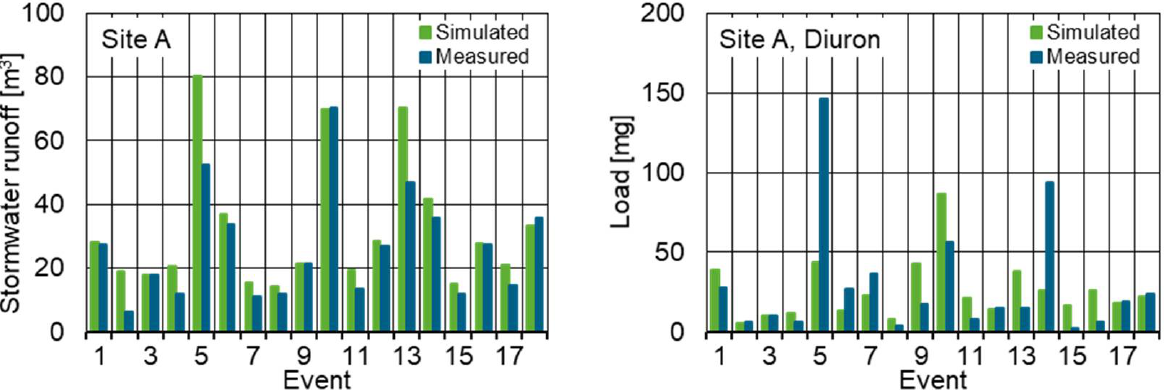
Figure 6. Measured and simulated stormwater runoff ( left ) and diuron load ( right ) in the stormwater of the entire catchment of site A for 18 analysed events.